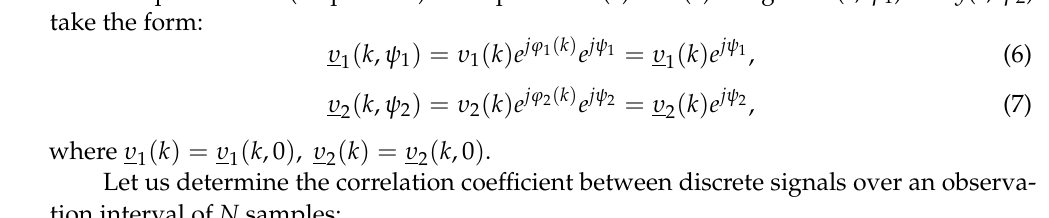
Figure 1. Simplified single-line diagram of a power transmission line in the case of a short circuit (SC). Complex vectors (amplitudes) for Expressions (4) and (5) of signals x ( k , ψ 1 ) and y ( k , ψ 2